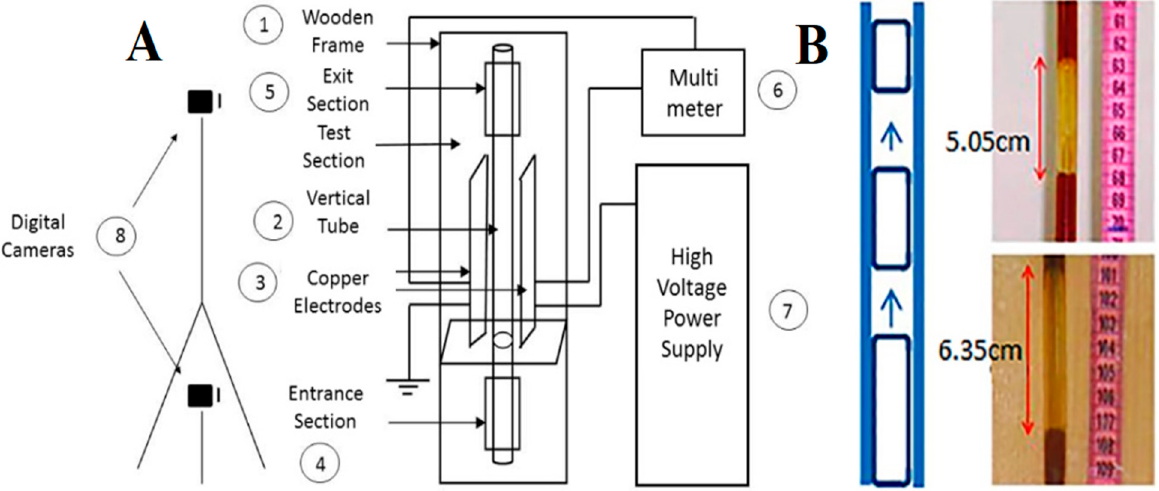
Figure 3. ( A ) Experimental setup; ( B ) digital picture of gas bubble length in the vertical pipe. Reprinted with permission from Ref. [45]. Copyright 2019, SciELO, Brazil.